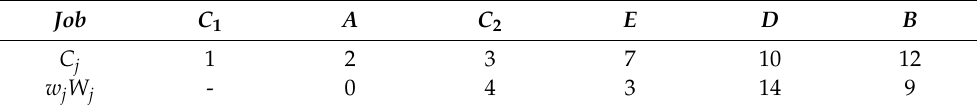
Table 3. Solution obtained with wSRPT